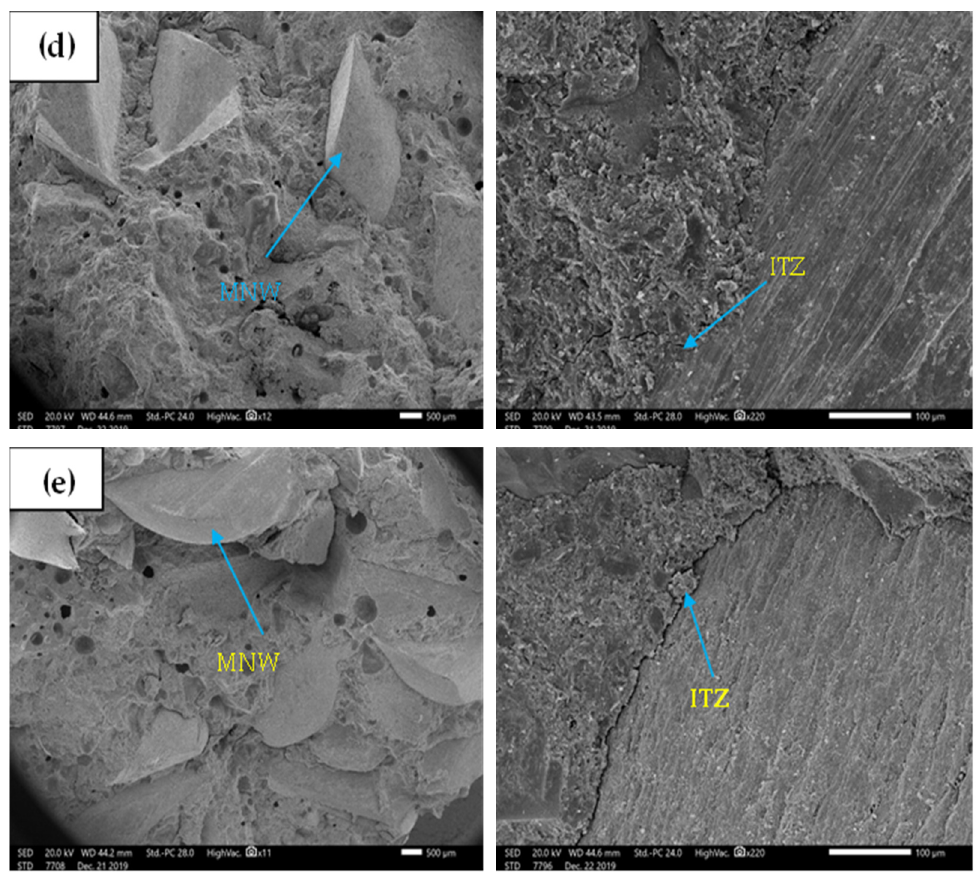
Figure 6. SEM images ITZ of MNW in cement paste: ( a ) M-0; ( b ) M-10MNW; ( c ) M-20MNW; ( d ) M-30MNW; ( e ) M-40MNW.